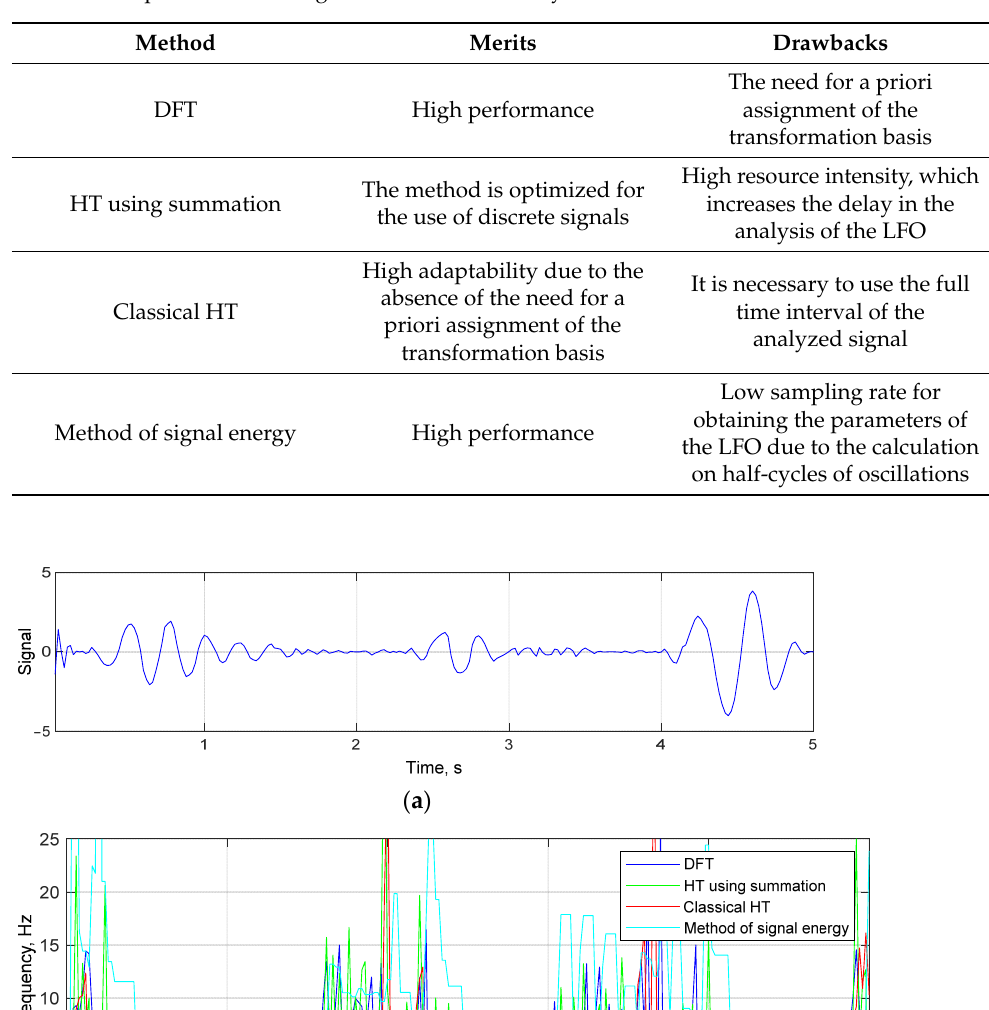
Table 1. Comparison of existing methods for LFO analysis.